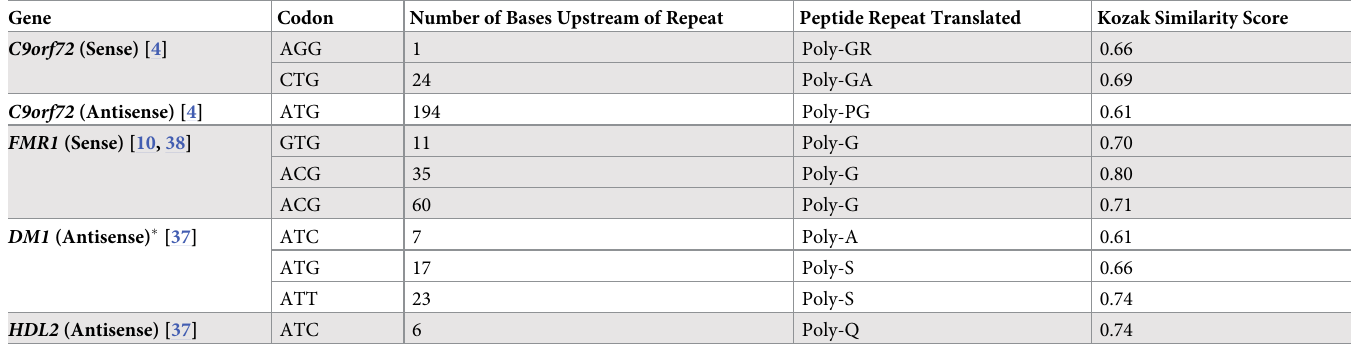
Table 1. Previously published repeat length-independent translation initiation